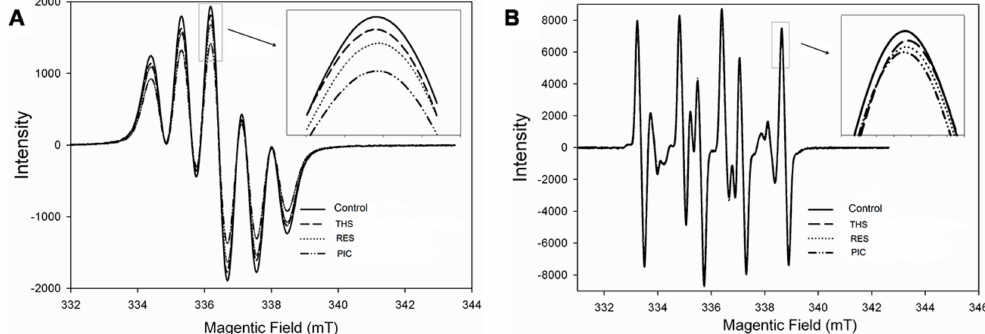
Electron paramagnetic resonance (EPR) spectra obtained from the reaction of stilbenoids with reactive oxygen species (ROS) ( A ) DPPH free radical and ( B ) OH free radical. The free radical scavenging activities were compared according to the decrease in peak